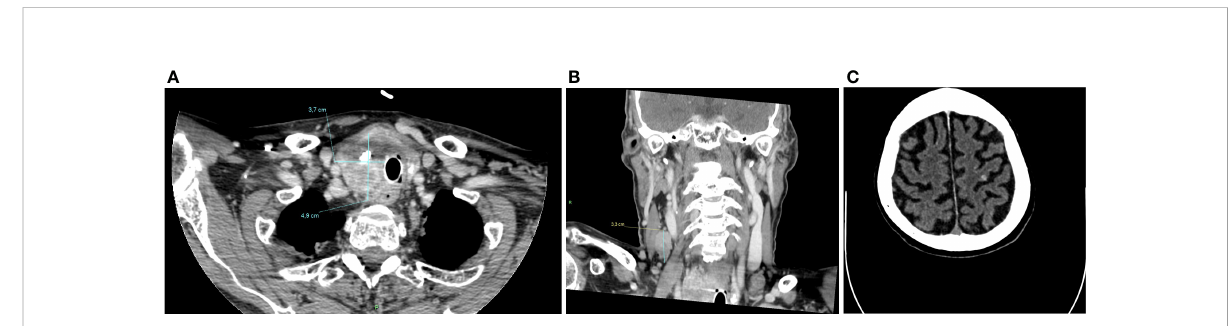
FIGURE 4 CT-scan performed in August 2021, after lenvatinib discontinuation, showing a dimensional increase of left thyroid lobe (4,9x3,7 cm) (A) , latero- cervical lymphadenopathies (maximum diameter of 3 cm) (B) and multiple brain and cerebellar metastases (C)